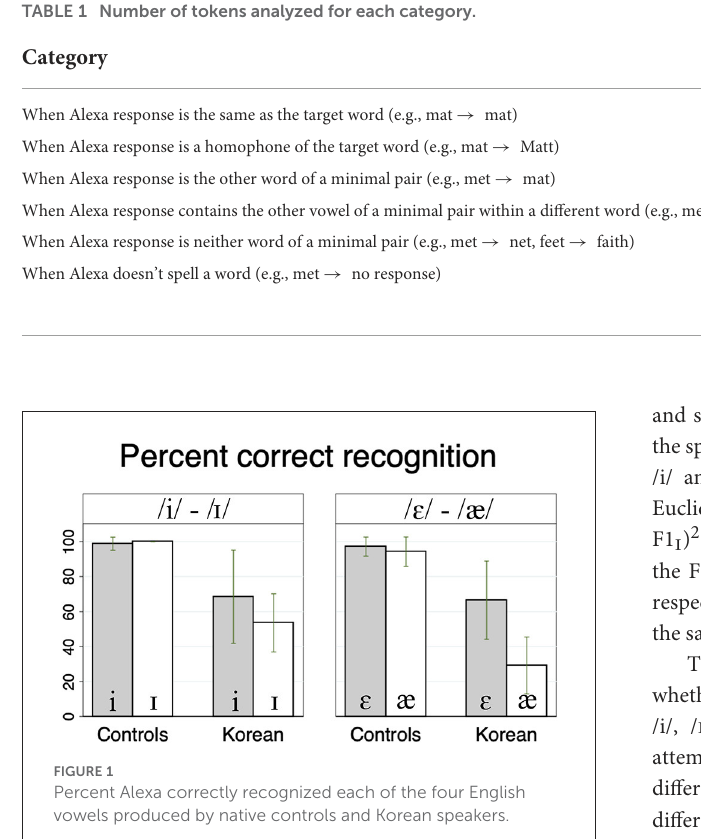
TABLE 1 Number of tokens analyzed for each category.